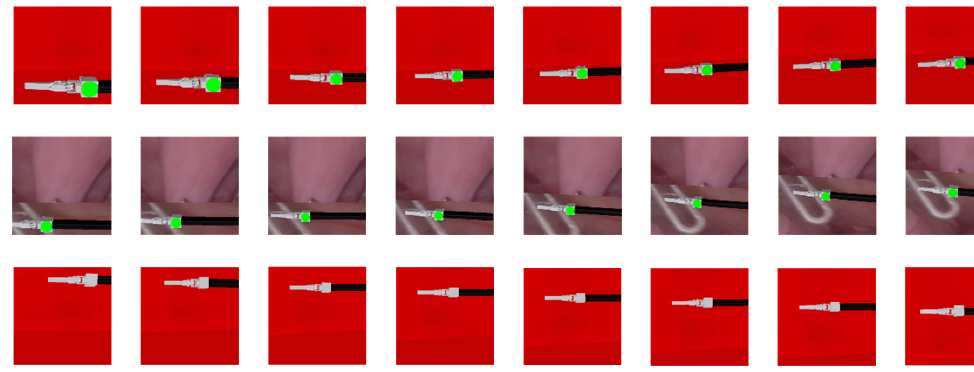
Figure 11. The adjustment process of the laparoscopic visual field.